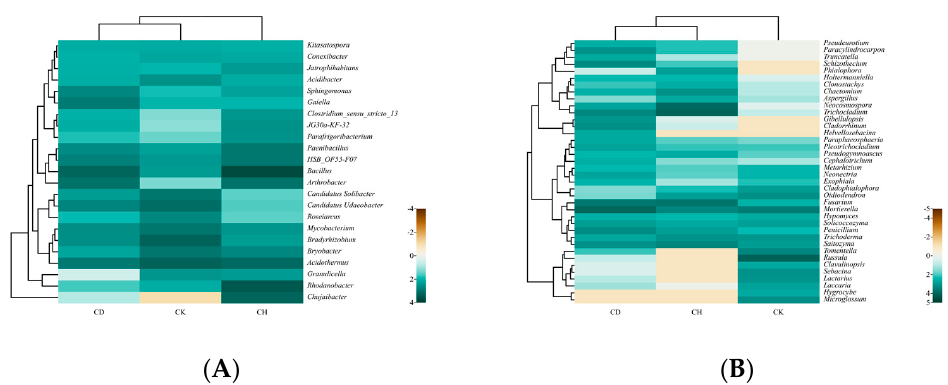
Figure 6. Heatmaps of soil bacterial and fungal communities at the genus level in the different soil samples. ( A ) Heatmap of the bacterial community at the genus level. ( B ) Heatmap of the fungal community at the genus level. The relative abundance in each sample was calculated on the basis of the percentage of the total effective sequences, which were classified using the RDP classifier and compared with the Silva database and the UNITE gene database. CH—biennial ginseng seedlings that were transplanted and then continuously cropped for four years in healthy ginseng rhizosphere woodland soil, CD—biennial ginseng seedlings that were transplanted and then continuously cropped for four years with severe soilborne disease in ginseng rhizosphere woodland soil, CK—soil sample from woodland without ginseng